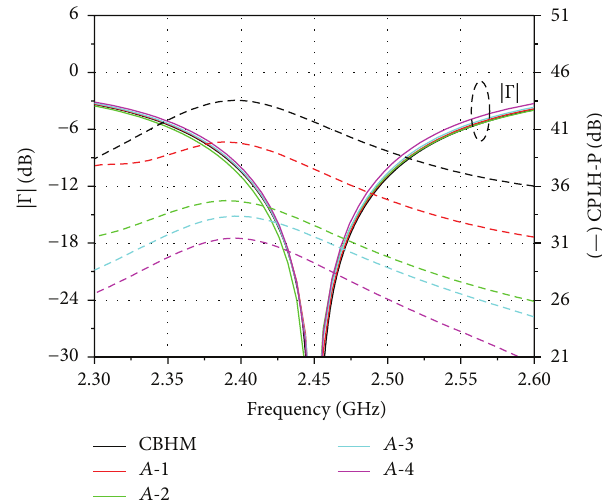
Figure 10: Geometry of the proposed SIW antenna.